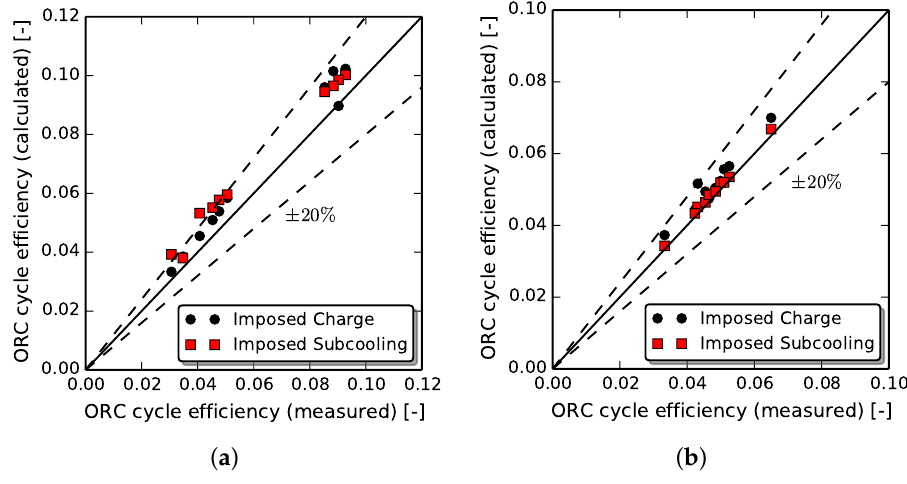
Figure 16. Parity plots ORC net efficiency: ( a ) ORC with R245fa at Ghent University; ( b ) ORC with R134a at the Herrick Laboratories, Purdue University. ( a ) Working fluid R245fa; ( b ) Working fluid